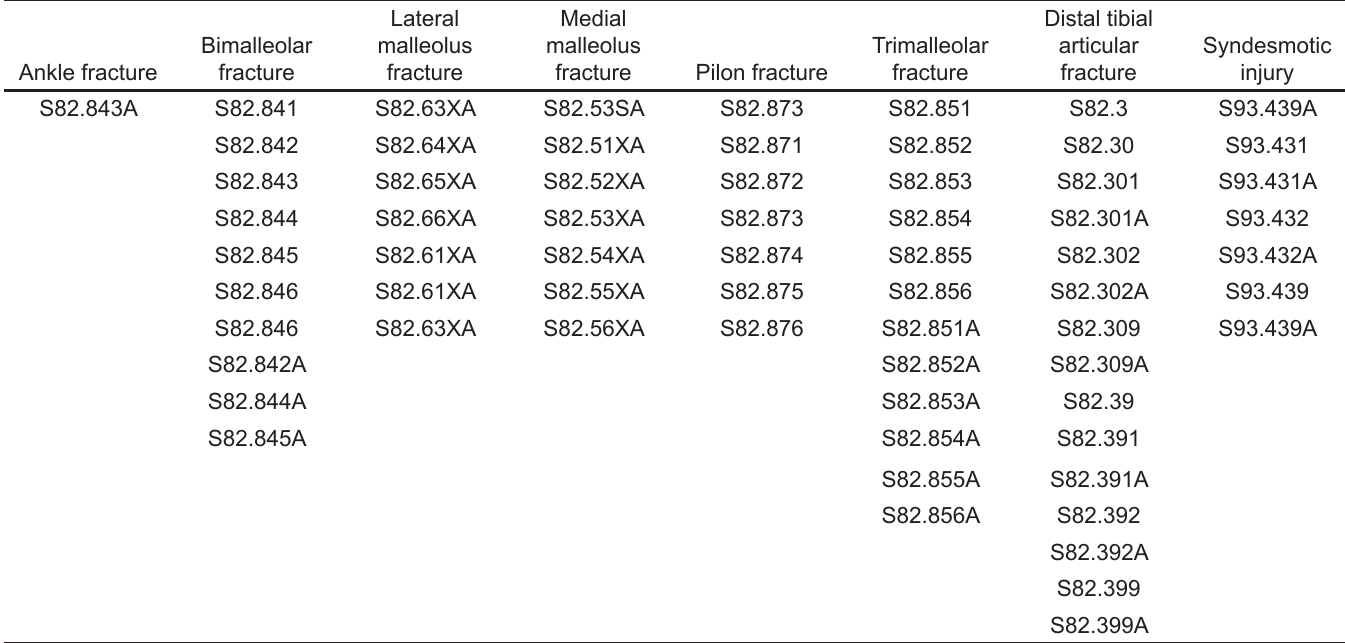
Table 1. ICD-10* codes used to capture patients with an unstable ankle injury.